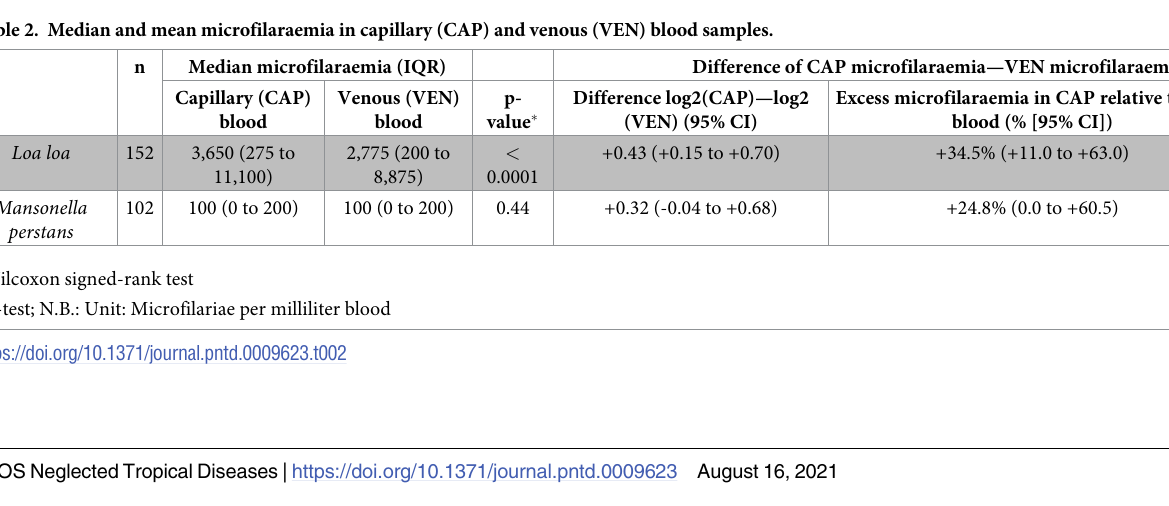
713 included participants 152 had a microscopically-confirmed infection with L . loa and 102 with M . perstans . Recruitment was stopped in 2019 due to logistical reasons despite of only having completed recruitment of 102 instead of the target sample of 120 individuals with con- firmed M . perstans infection.